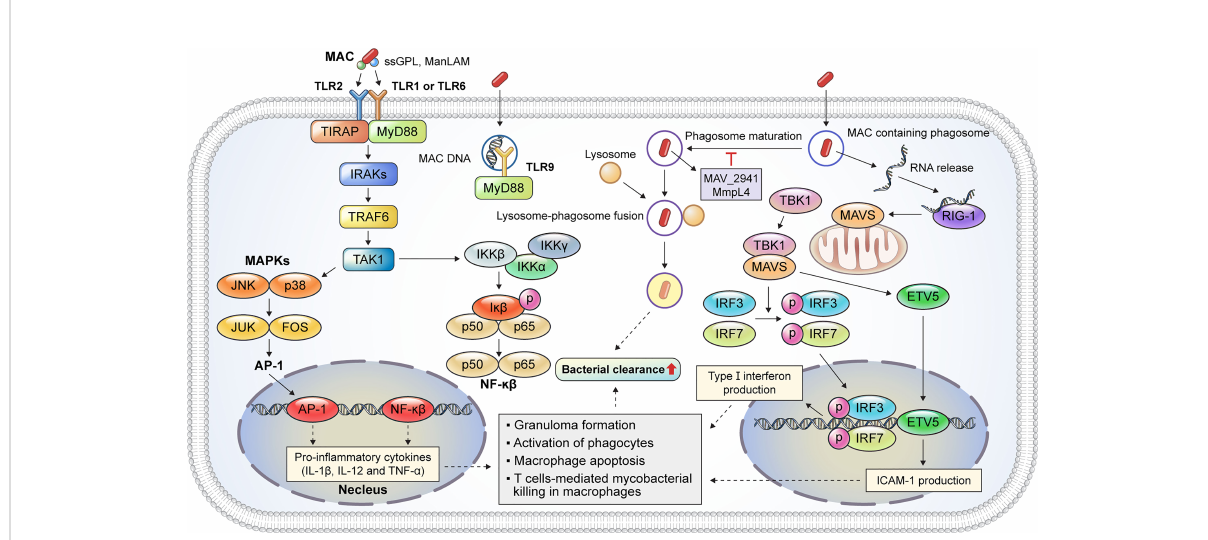
FIGURE 2 Representative host protective innate immune mechanisms of macrophages against MAC infection. Macrophages are immune cells that play a key role in host innate defense mechanisms against MAC infection. TLR2 signaling is activated by the binding of mycobacterial PAMP, such as ssGPL and ManLAM, to TLR heterodimers, which induces MyD88-dependent cascade that activates the kinase activity of the IRAK complex. TLR9 recognizes MAC DNA and promotes a MyD88-dependent response. The IRAK complex activates TRAF6, which, in turn, activates TAK-1. Activation of TAK-1 leads to the translocation of AP-1 and NF- kb into the nucleus to produce pro-in fl ammatory cytokines, such as IL-1 b , IL-12, and TNF- a . These cytokines augment the antimycobacterial response, including granuloma formation, phagocyte activation, and apoptosis. MAC-containing phagosomes undergo maturation and fusion events to eliminate the phagocytosed bacteria. M. avium proteins such as MAV_2941 and MMPL4 inhibit phagosome maturation, which subsequently promotes intracellular survival. The recognition of bacterial RNA plays a critical role in the innate immune response during MAC infection. The released MAC RNA binds to RIG-I, which induces a MAVS- dependent response, thereby activating TBK-1. Activated TBK-1 and MAVS promote the nuclear translocation of IRF3/7 and ETV5, leading to type I interferon and ICAM-1 expression, respectively. Taken together, the innate immune response induced by TLR2/1, TLR2/6, and TLR9 signaling and host cytosolic RNA-sensing pathways contributes to bacterial clearance during MAC infection. MAC, Mycobacterium avium complex; TLR, Toll-like receptor; PAMP, pathogen-associated molecular pattern; ssGPL, species-speci fi c glycopeptidolipid; ManLAM, mannose- capped lipoarabinomannan; IRAK, interleukin-1 receptor-associated kinase; TRAF6, tumor necrosis factor receptor (TNFR)-associated factor 6; TAK-1, transforming growth factor- b (TGF- b )-activated kinase 1; AP-1, activator protein 1; NF, nuclear factor; IL, interleukin; TNF, tumor necrosis factor; RIG-I, retinoic acid inducible gene-I; MAVS, mitochondrial antiviral signaling protein; TBK-1, TANK-binding kinase-1; IRF, interferon regulatory factor; ETV, Ets variant; ICAM, intracellular adhesion